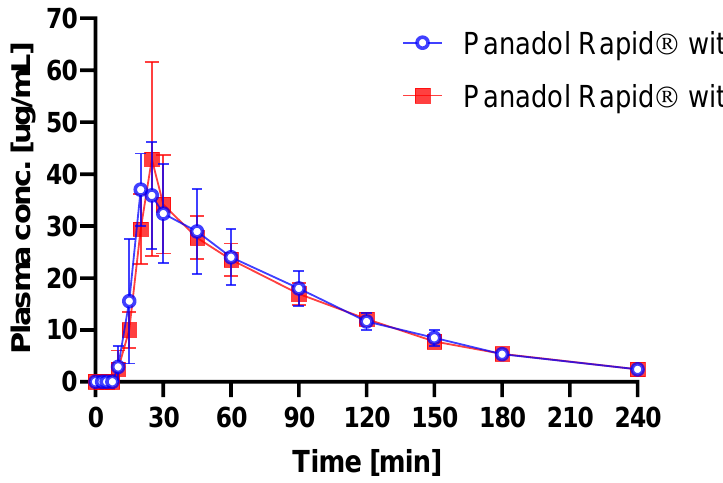
Figure 6. Plasma concentration of paracetamol in beagle dogs after oral administration of Panadol Rapid with (o) and without ( ■ ) capsule endoscopy (mean ± standard deviation, n = 3).